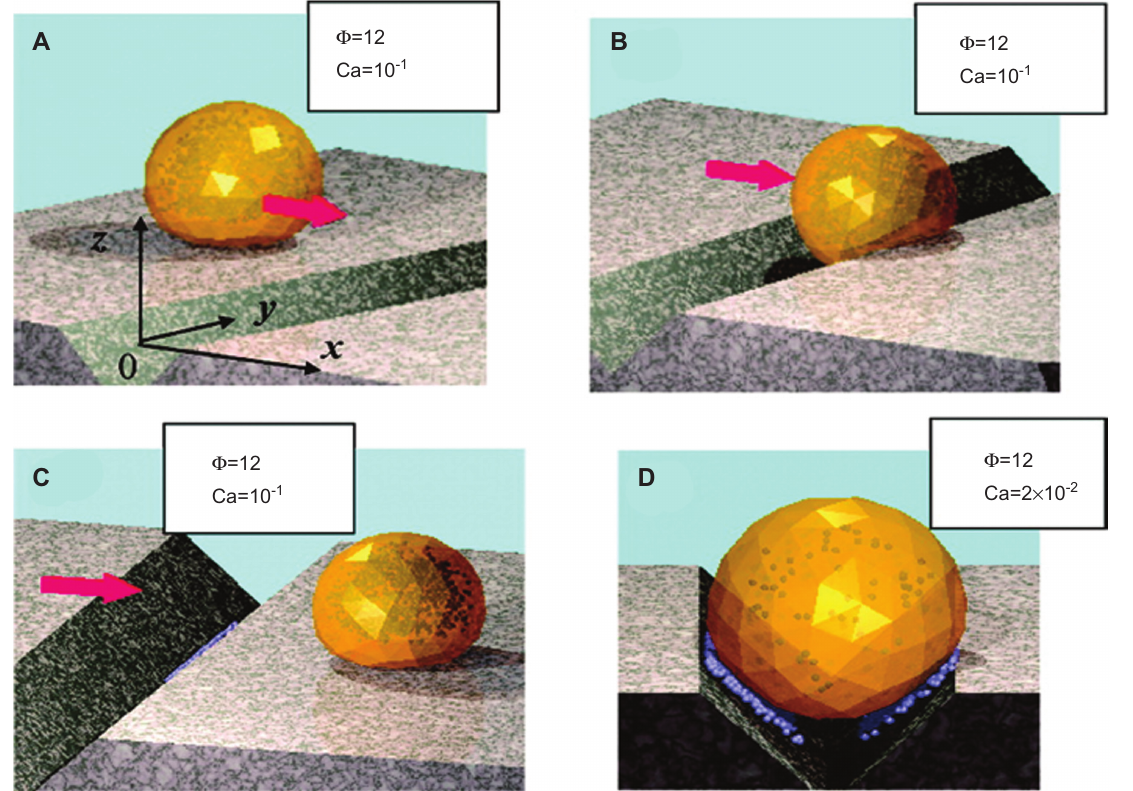
Figure 16 Graphical image of the simulation that shows the movement of a capsule to a microcrack from its initial position (A) to the crack (B), its motion further away from the crack (C), and the release of the nanoparticles (reprinted with permission from [84]). Copyright 2010, American Chemical